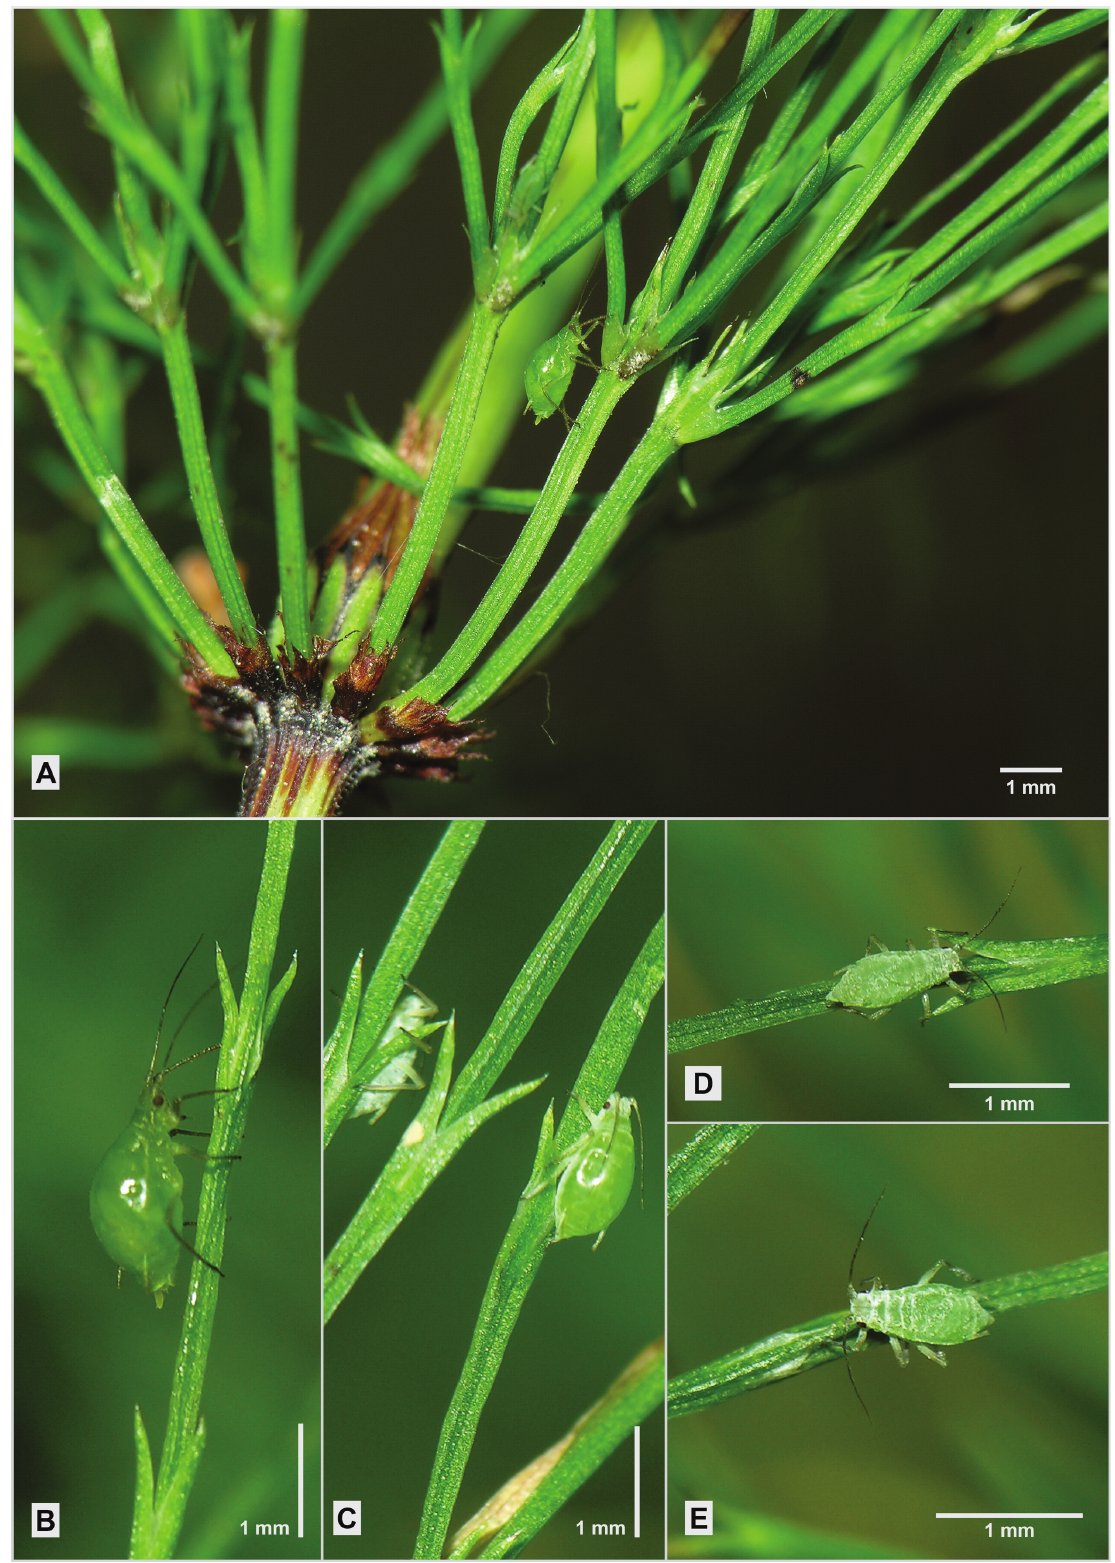
Fig. 26. Macrosiphum equiseti (holman, 1961) on Equisetum sylvaticum . A–C . Apterae. D–E .